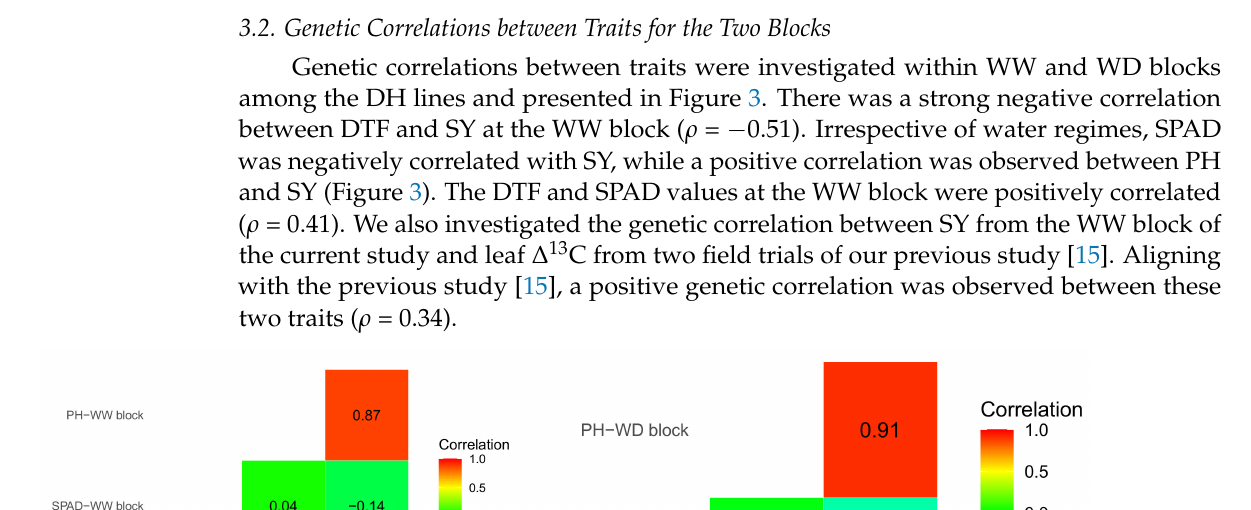
Figure 2. Per cent seed yield decrease of the water-deficit (WD) block compared to the well-watered (WW) block for check cultivars, parental lines and some high and low per cent seed yield decreased DH lines of interest.